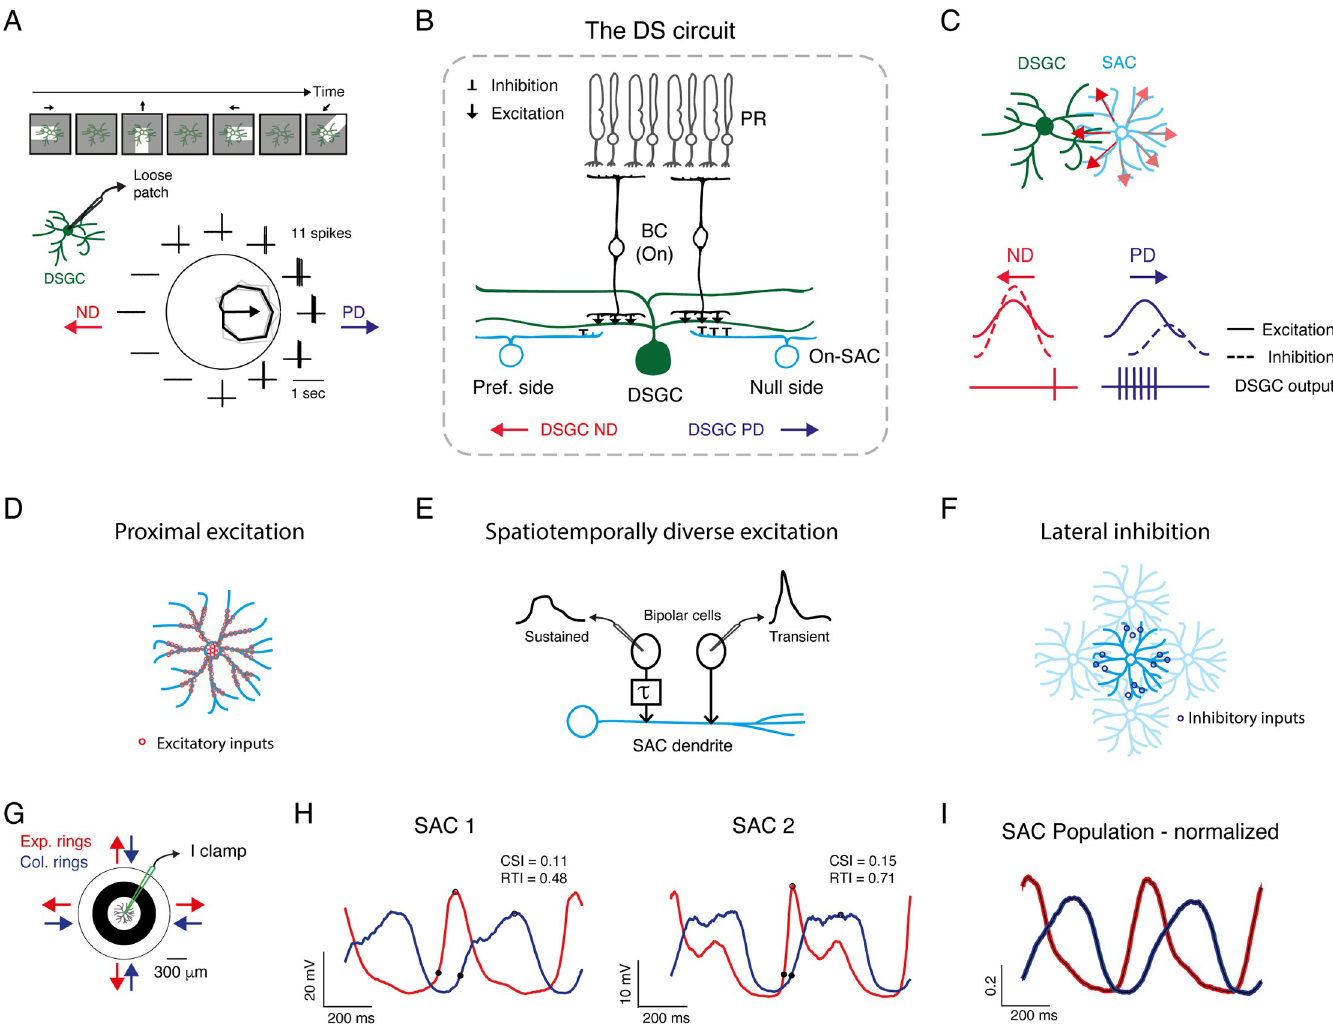
Fig 1. Mechanisms for direction selectivity and centrifugal preference in experimentally recorded SAC. A. Example directional tuning of a DSGC. Top: Illustration of a moving bar stimulation. Bottom: Spiking activity recorded in loose-patch mode. The polar plot represents the mean spike count (black) in response to the leading edge of a white bar (On response) moving in 12 directions; grey lines represent single repetitions (4 in total); the arrow represents the preferred direction. The surrounding traces depict one representative recording trace. B. A cross-section of the direction selective circuit. Only inputs to DSGCs from the On layer are illustrated for simplicity. DSGCs receive excitatory inputs ( # ) from bipolar cells and inhibitory inputs ( ? ) from SACs. SACs on the null side form stronger inhibitory connections than SACs on the preferred side. C. Schematic of a DSGC innervated by a null-side SAC, top view. SAC processes respond with greater depolarization to centrifugal motion (red arrows), corresponding to the DSGC’s null direction. Bottom: illustration of the excitatory and inhibitory inputs to DSGC during preferred and null motion, and their resulting spiking activity. D-F. Illustration of the mechanisms that are thought to underlie SAC CF preference: proximal distribution of excitatory inputs ( D ), differential input kinetics ( E ), and SAC-SAC inhibitory connections ( F ). G. Experimental design: current-clamp recordings were performed from On-SACs in response to expanding and collapsing rings centered on the cell soma. H. Two examples of SAC voltage responses to expanding (red) and collapsing (blue) rings stimulation, averaged over cycles and repetitions. Responses to two cycles of the rings are shown. Black dots denote the initial response and the peak. I. Normalized waveforms (mean ± SEM) of all experimentally recorded SAC responses to expanding and collapsing rings averaged over 1 second (n = 27 cells). DSGC: direction selective retinal ganglion cell; SAC: starburst amacrine cell; BC: bipolar cell; PR: photoreceptor; PD: preferred direction; ND: null direction.